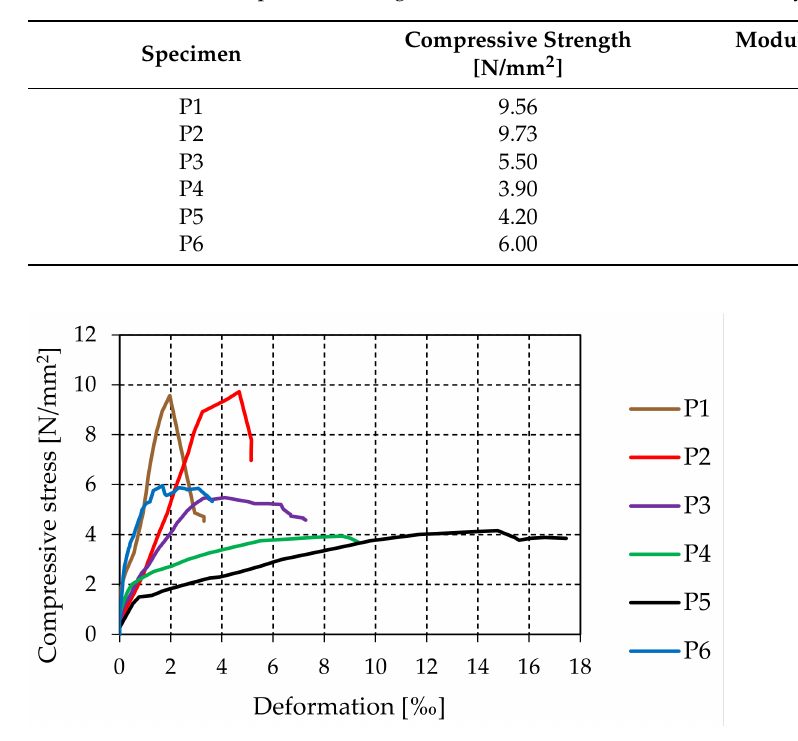
Figure 2. σ - ε diagrams of masonry prisms